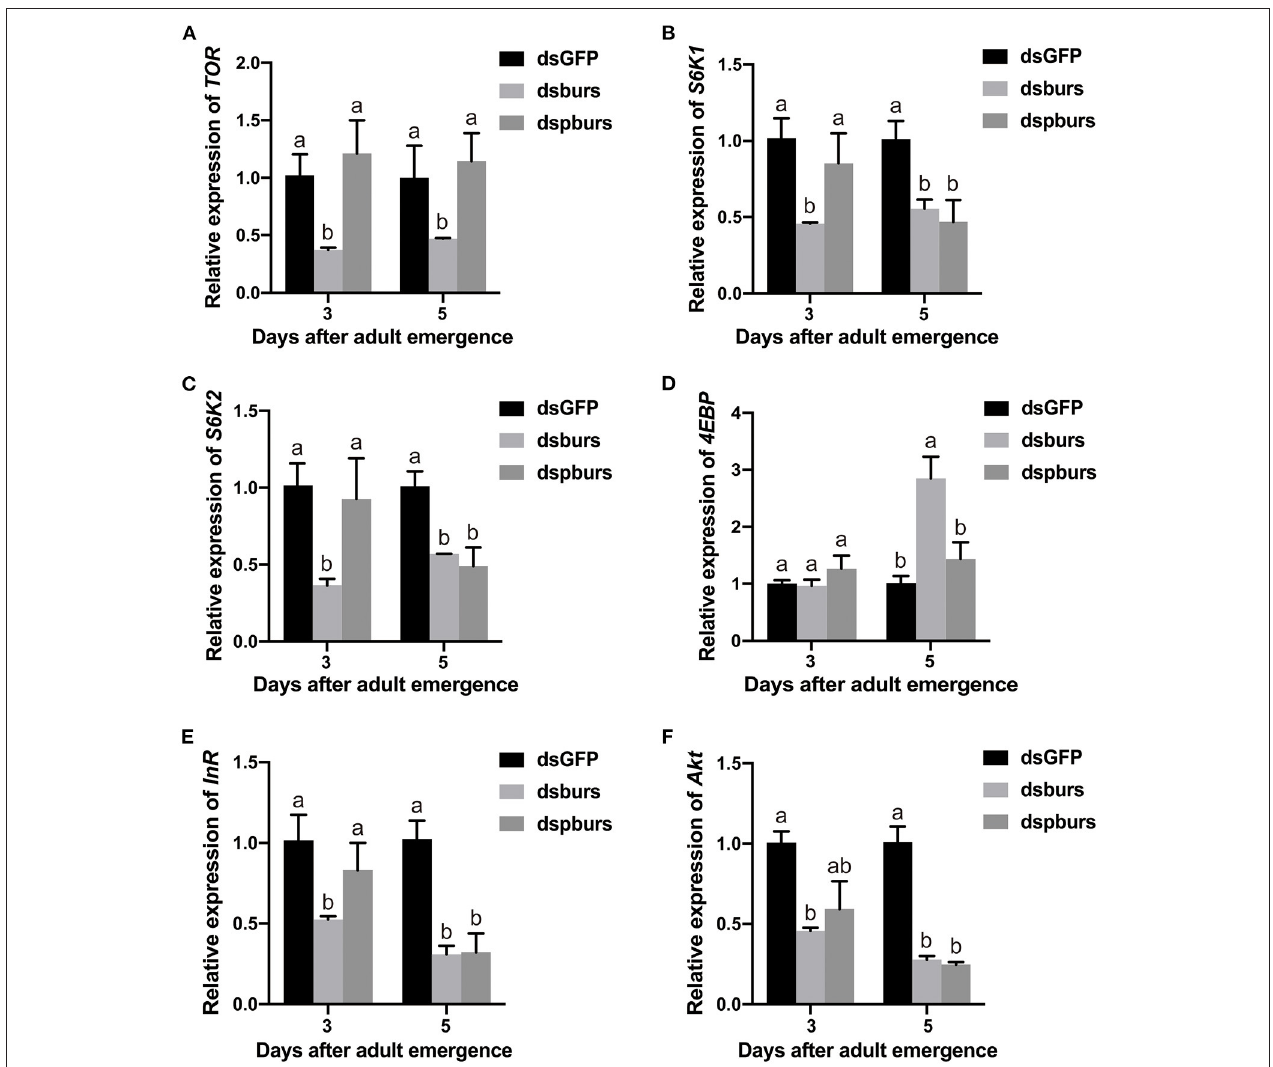
FIGURE 6 | Effects of burs and pburs RNAi on the insulin/insulin-like signaling (IIS)/target of rapamycin (TOR) pathway. (A–D) Relative expression levels of the TOR pathway genes TOR , S6K1 , S6K2 , and 4EBP in 3- and 5-day female adults after the silencing of burs or pburs. (E,F) Relative expression levels of the IIS pathway genes insulin receptor ( InR ) and protein kinase B ( Akt ) in 3- and 5-day female adults after burs or pburs silencing. Different letters on the bars indicate the means ± SEM, which are significantly different ( p < 0.05) among treatments by ANOVA.